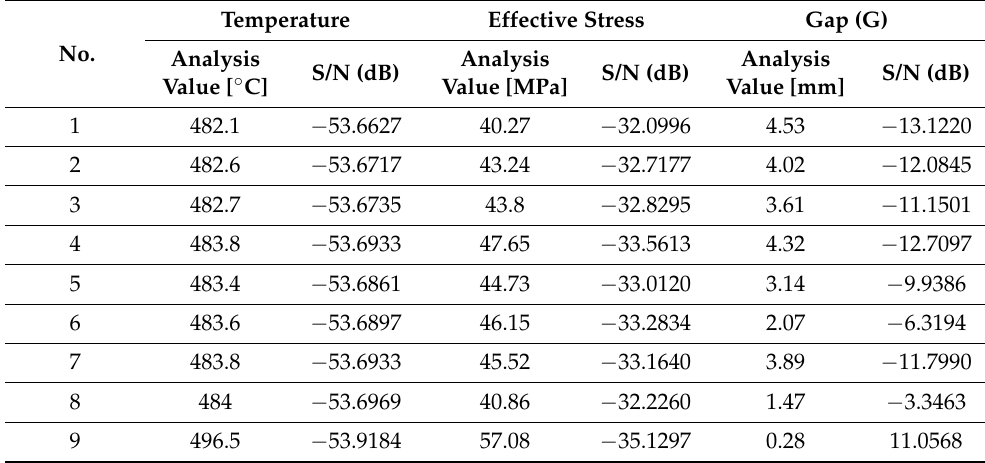
Table 8. Analysis values and S/N